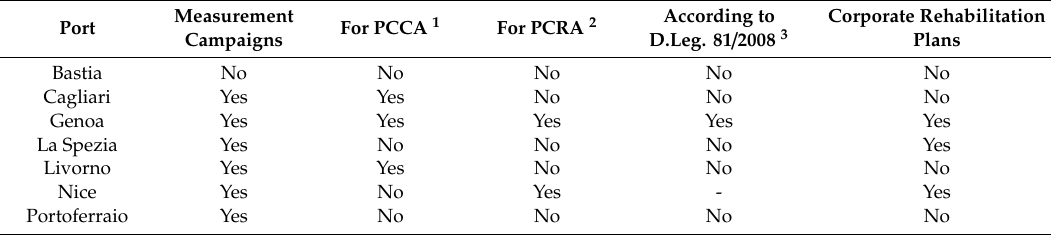
Table 4. The measurement campaign carried out in the North Tyrrhenian’s